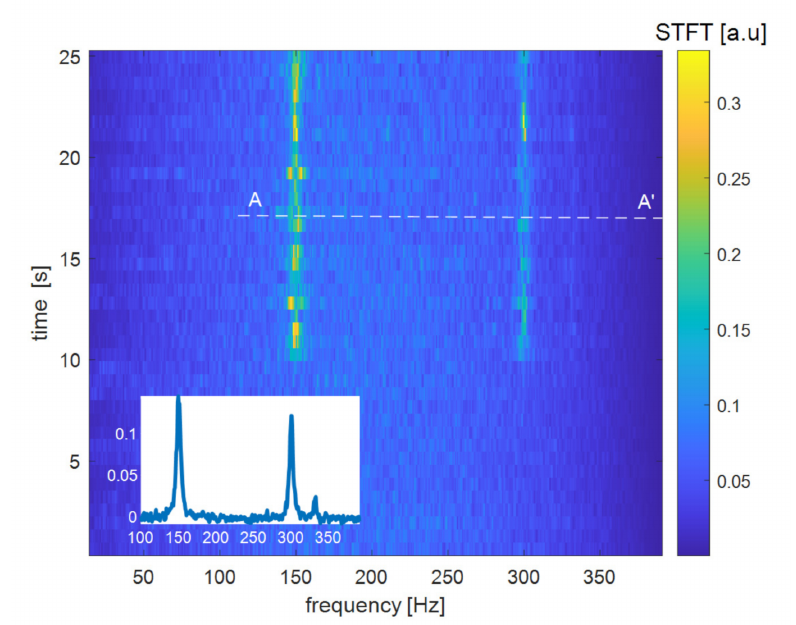
Figure 5. Spectrogram of the φ -OTDR signal acquired over the vibrating position. The inset shows the data corresponding to the white dashed line A-A’. STFT stands for short-time Fourier transform.